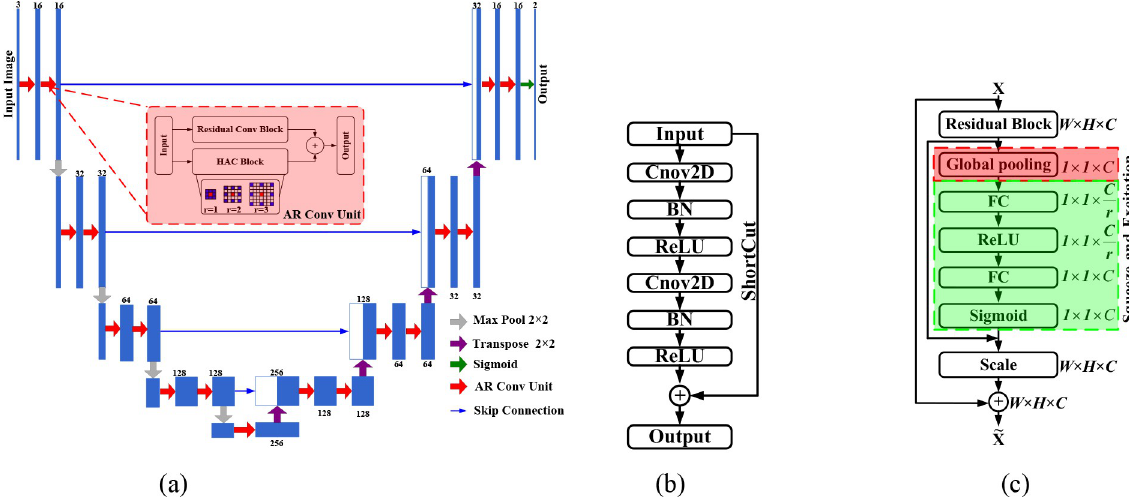
Algorithm 1: Algorithm of the proposed ARU convolution